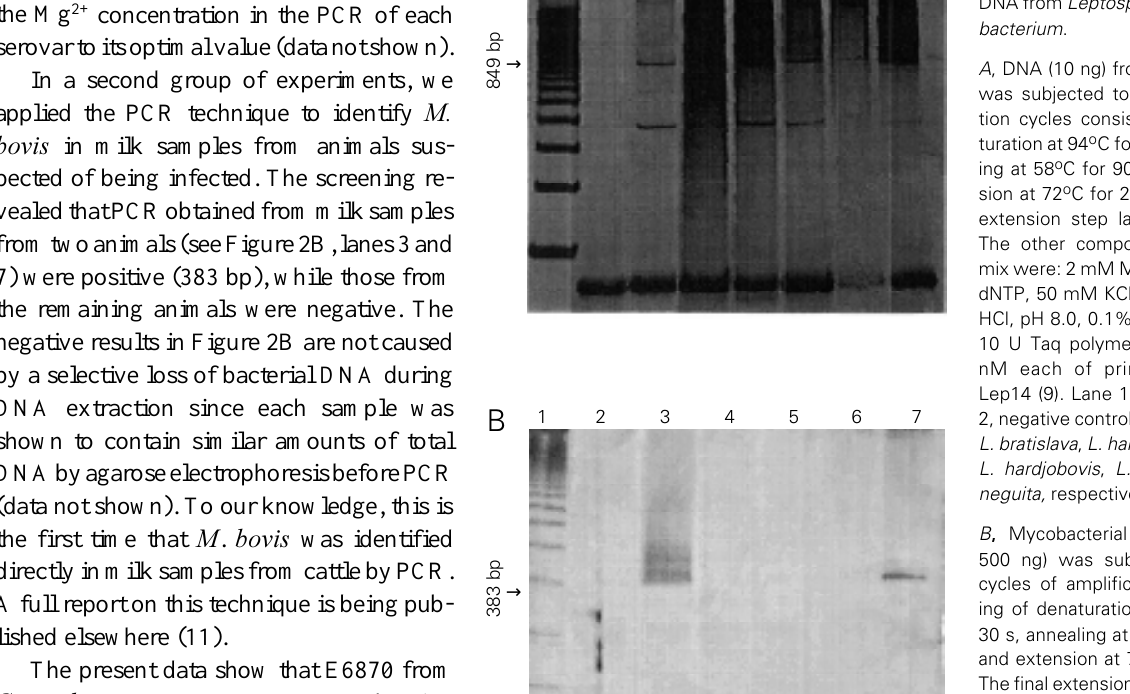
Figure 2 - PCR amplification of DNA from Leptospira and Myco- bacterium